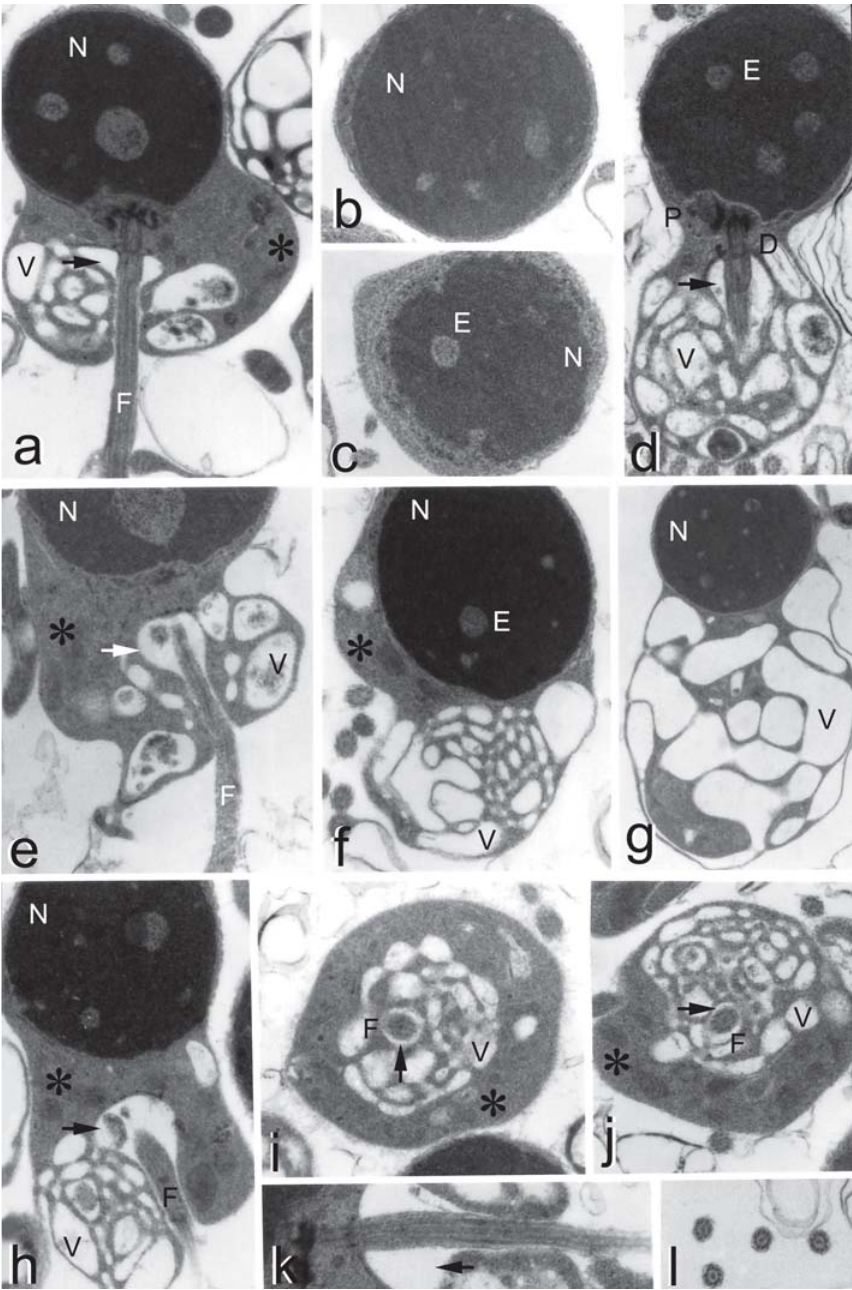
Fig. 9. Spermatozoa of Megalechis thoracata . a ) Longitudinal section. b and c ) Nucleus in cross sections. d ) Detail of centriolar arrangement. e to j ) Midpiece in longitudinal and transverse sections showing mitochondria, elongated vesicles, and cytoplasmic channel. k and l ) Flagellum in longitudinal and cross sections. ( a to e , h ) X 17000; ( f, i, j ) X 18400; ( g ) X 11925; ( k ) X 23000; ( l ) X 13950. D: distal centriole; E: electron-dense structure; F: flagellum; N: nucleus; P: proximal centriole; V: vesicles; Asterisk: mitochondria, Arrow: cytoplasmic